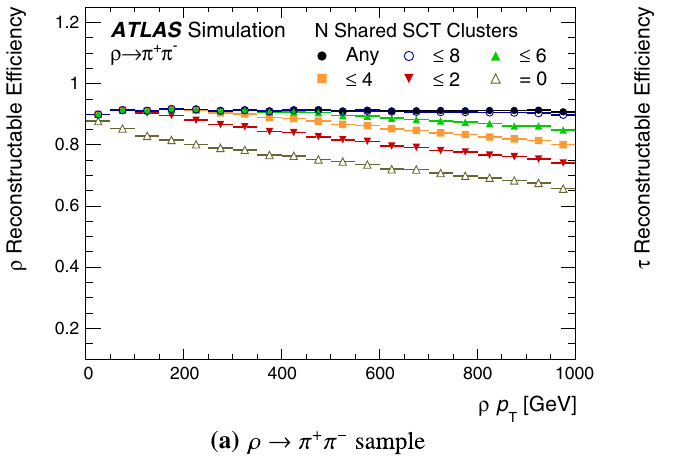
Fig. 11 The reconstructable efficiency, defined as the efficiency to reconstruct all of the charged decay products of the parent particle, is shown for the ρ and three-prong τ samples with various limits on the